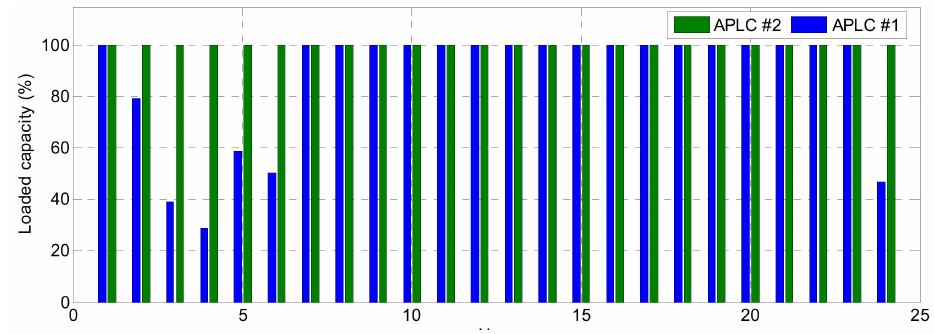
Figure 10. The loaded capacity of the APLCs for harmonic filtering in Case